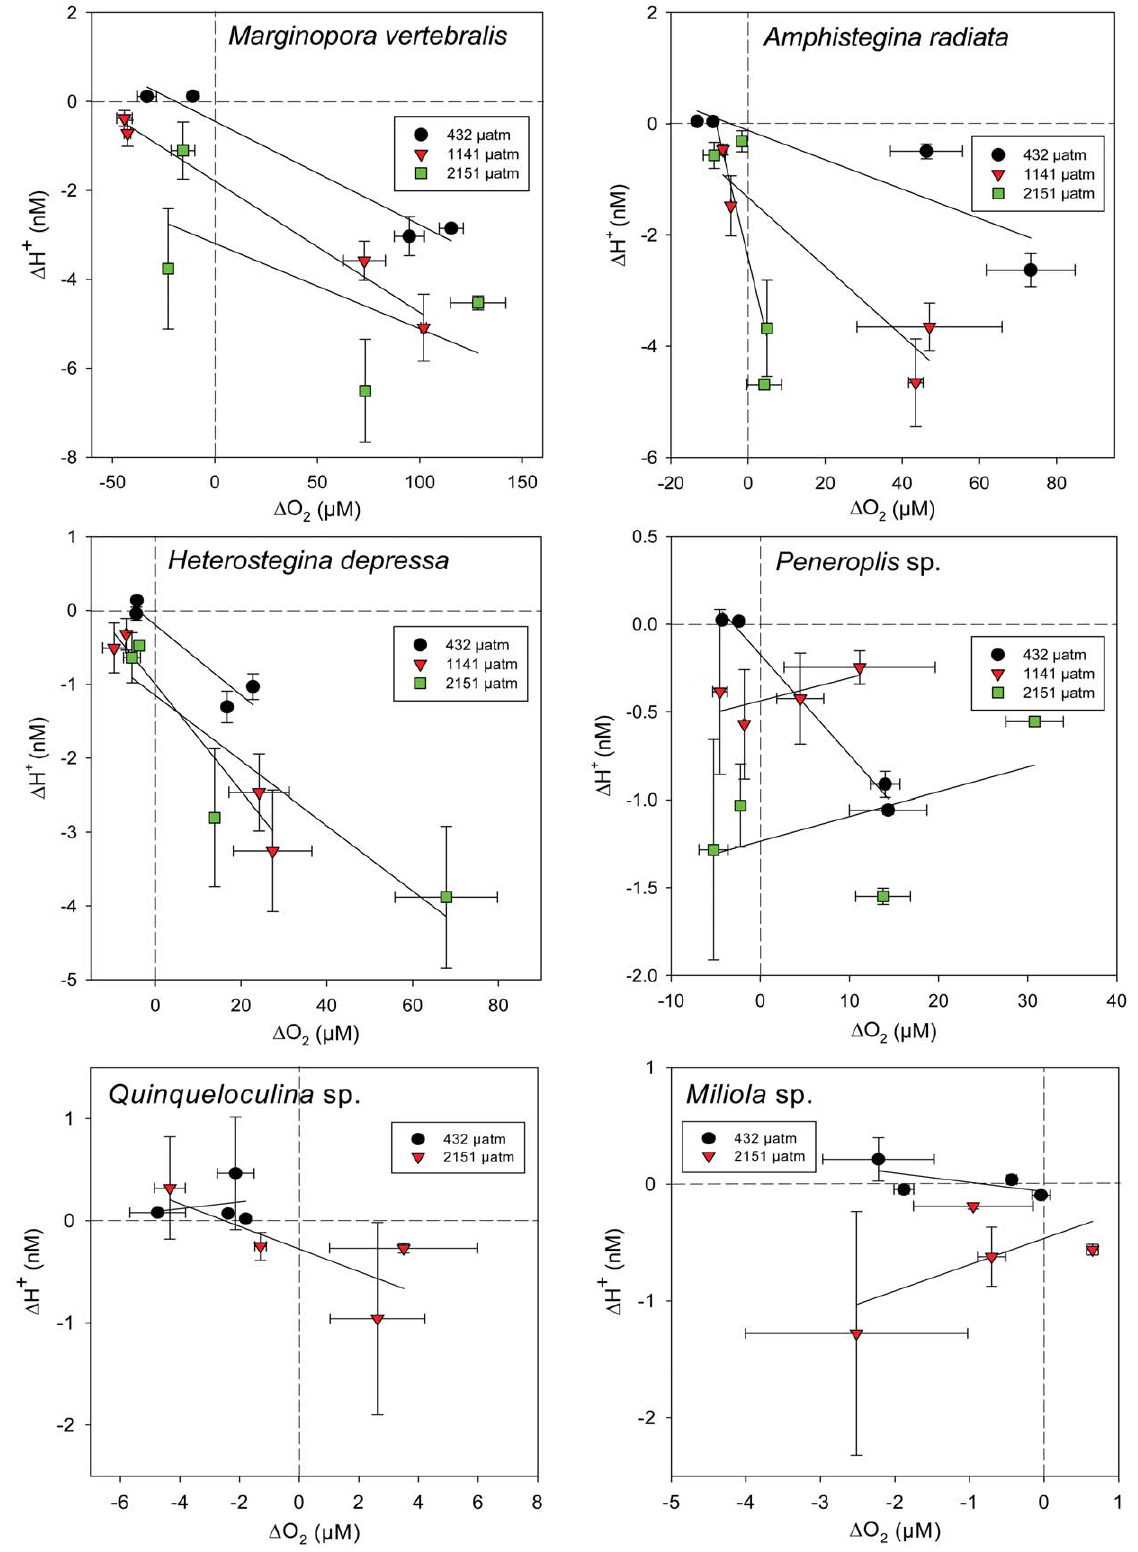
Figure 7. Relationship between mean D H + and D O 2 at different pCO 2 treatment groups for light (30 m mol photons m 2 2 s 2 1 ) and dark conditions. Each point represents an individual foraminiferal test (mean 6 SE, n=2–4). Solid lines indicate linear correlations for the different pCO 2 treatment groups, dashed lines indicate the respective D O 2 and D H + zero-lines.